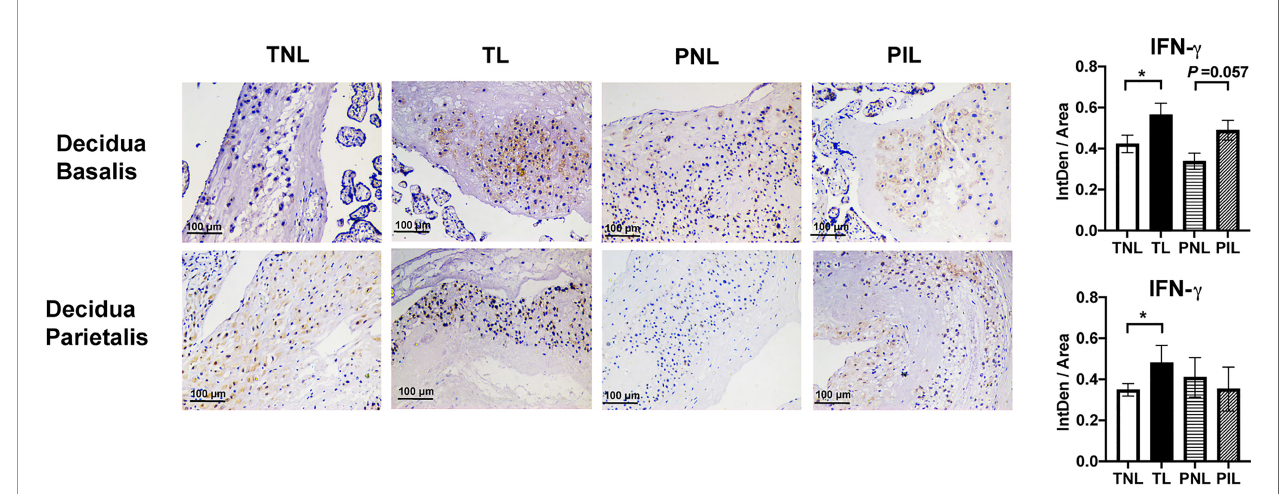
FIGURE 5 | IHC Staining of IFN- g in the Decidua basalis and Parietalis during Term and Preterm Labor. Comparison of the expression of IFN- g in the decidua basalis and parietalis among the four groups. Continuous variables were presented as mean ± standard deviation. Differences are indicated: * P < 0.05. IntDen: Integrated